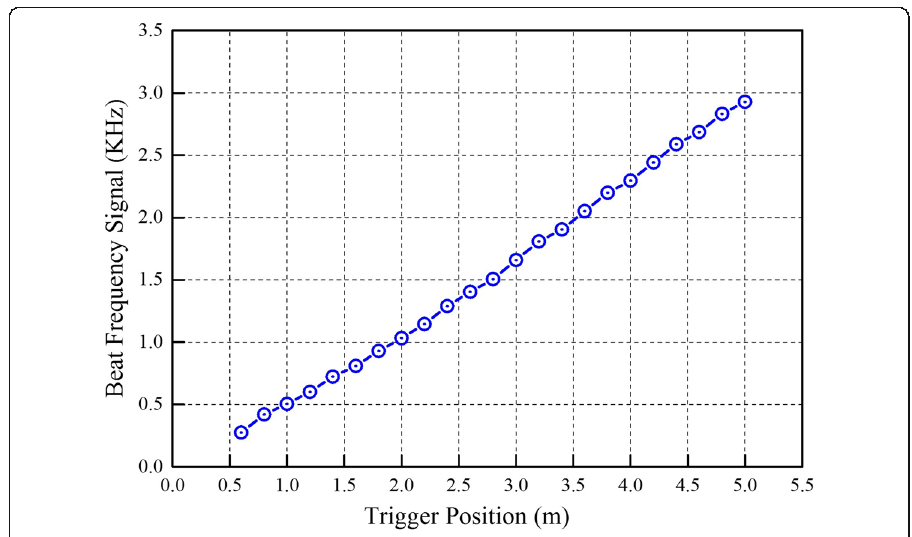
Fig. 12 Measured relationship between trigger position and beat frequency signal